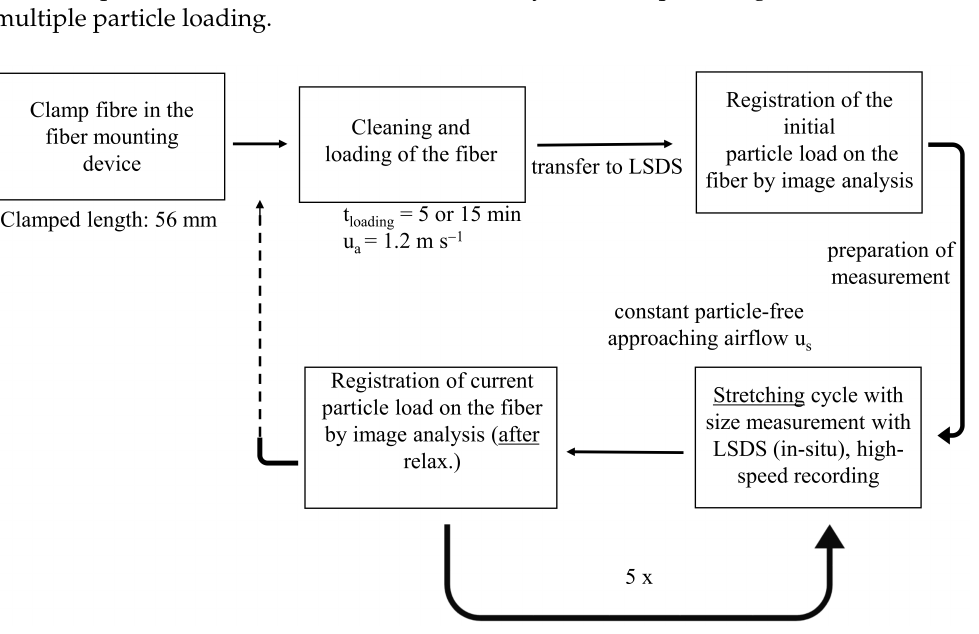
Figure 4. Procedure of a stretching experiment including the multiple stretching cycles (5 times).